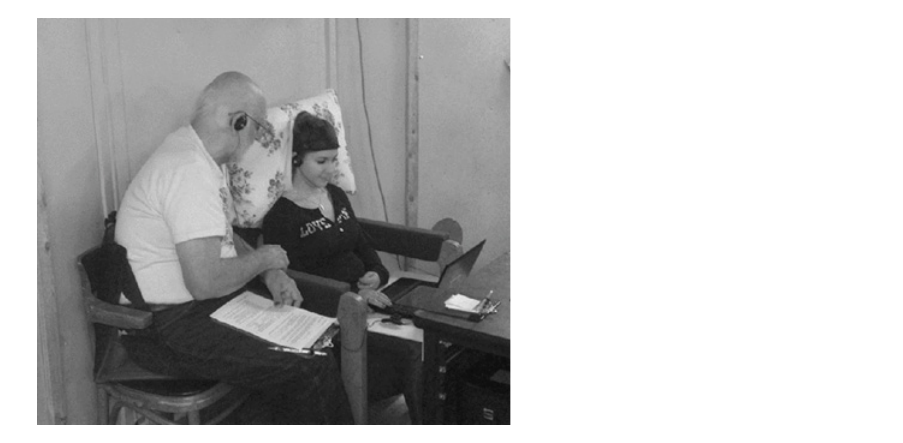
laptop placed on a flat support located on her lap.